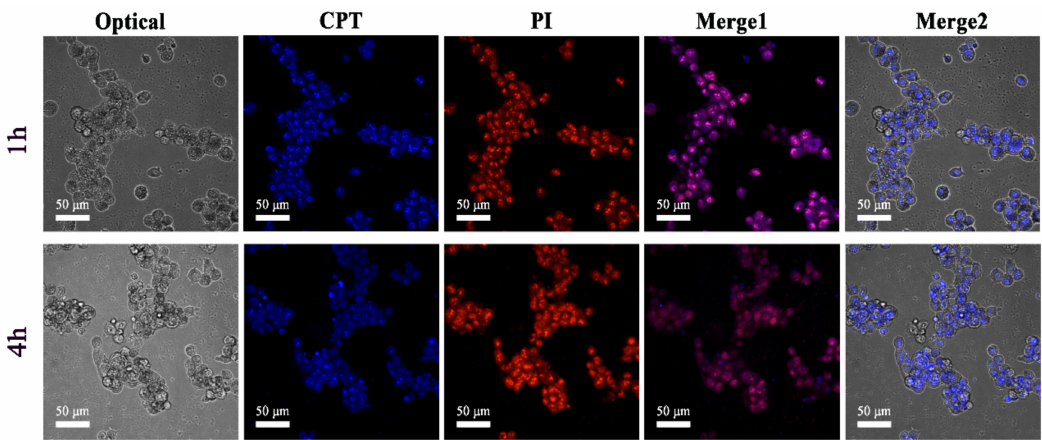
Figure 4. Cellular uptake of CPT-HT-J-ZL 12 in LNCaP-FGC (high expression of PSMA) cells. CLSM images of LNCaP-FGC cells incubated with CPT-HT-J-ZL 12 (10 µ M) for 1 and 4 h. Nuclei were stained by PI (red); the blue color was indicative of CPT . CPT : false-color green. For CPT :